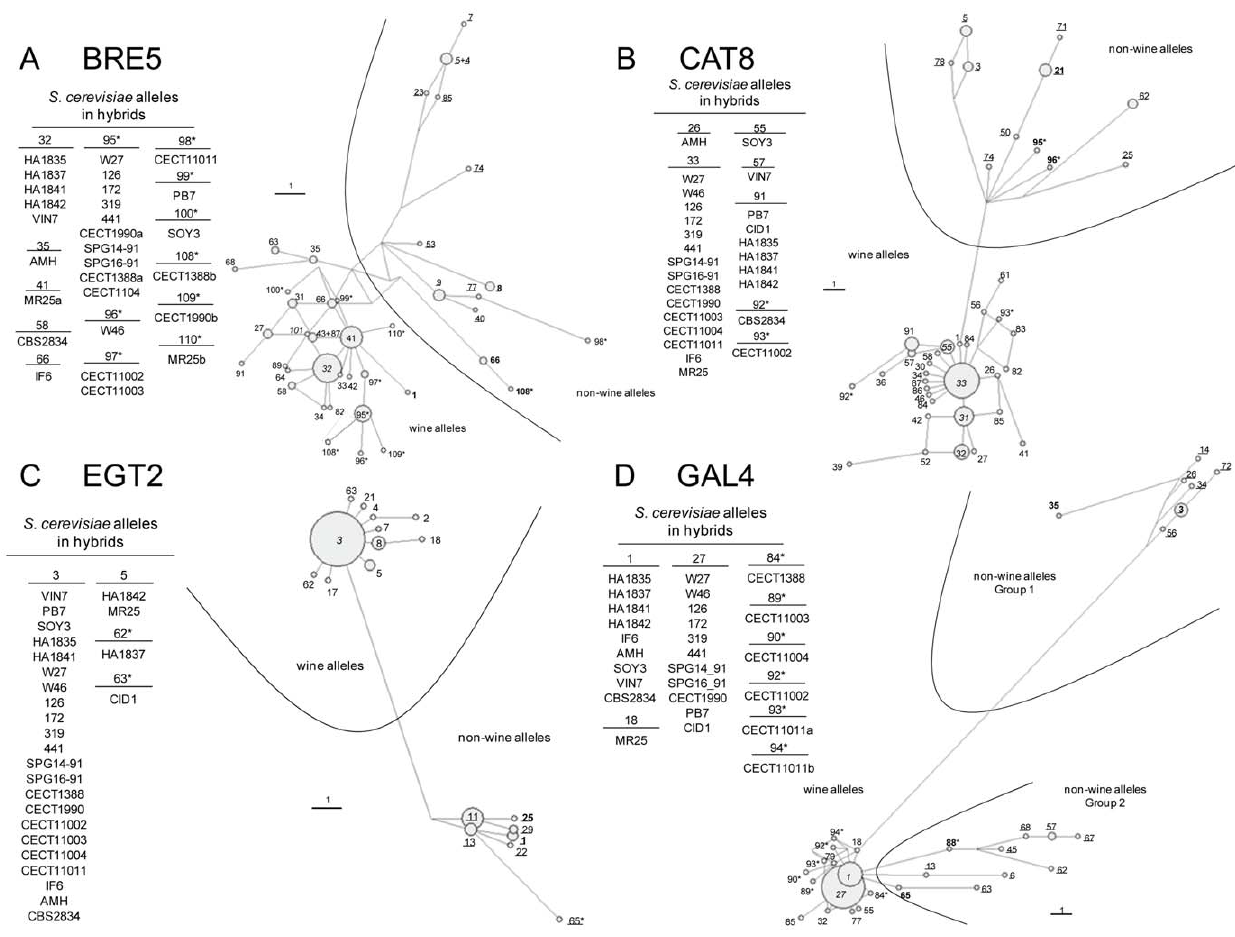
Figure 1. Median Joining (MJ) networks obtained for genes BRE5 (A), CAT8 (B), EGT2 (c) and GAL4 (D) from hybrid strains and representative wine and non-wine allele sequences according to Arias [ 8 ] . Strains representative of each different origin according to Liti et al. [9] and the alleles from wine strain EC1118 [24] were also included. Asterisks indicate new alleles not reported by Arias [8]. Numbers in italics indicate those alleles exhibited by wine strains from Liti et al. [9] and Novo et al. [24]. Numbers in bold indicate alleles present in non-wine strains from Liti et al. [9]. Underlined numbers correspond to alleles classified as ‘‘non-wine’’ in Arias [8].